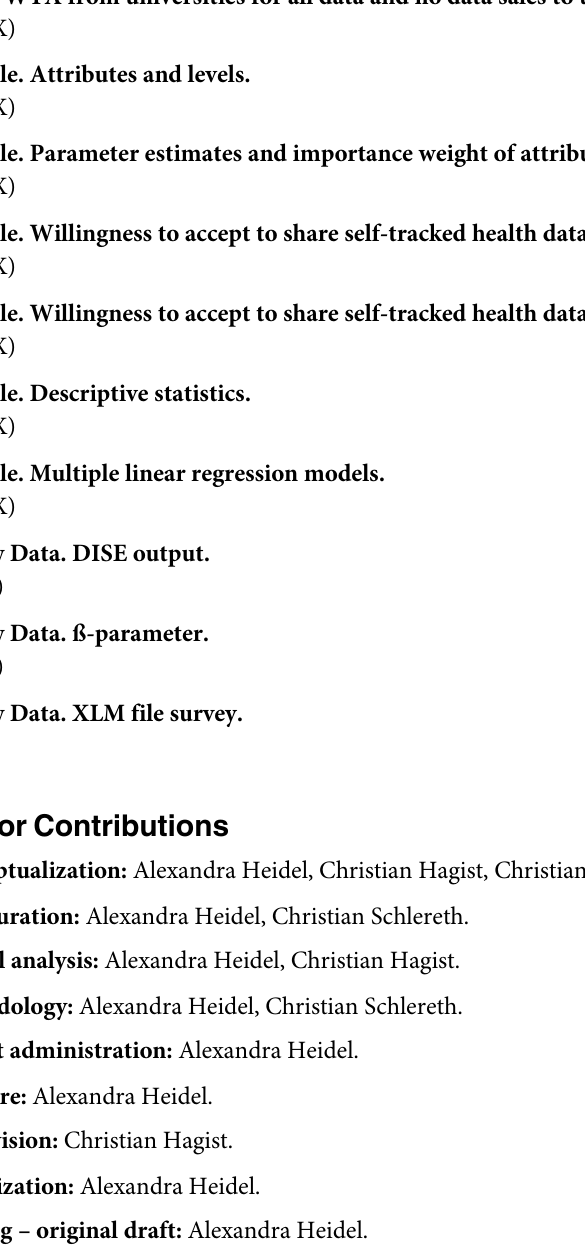
S2 Table. Parameter estimates and importance weight of attributes—Main study.